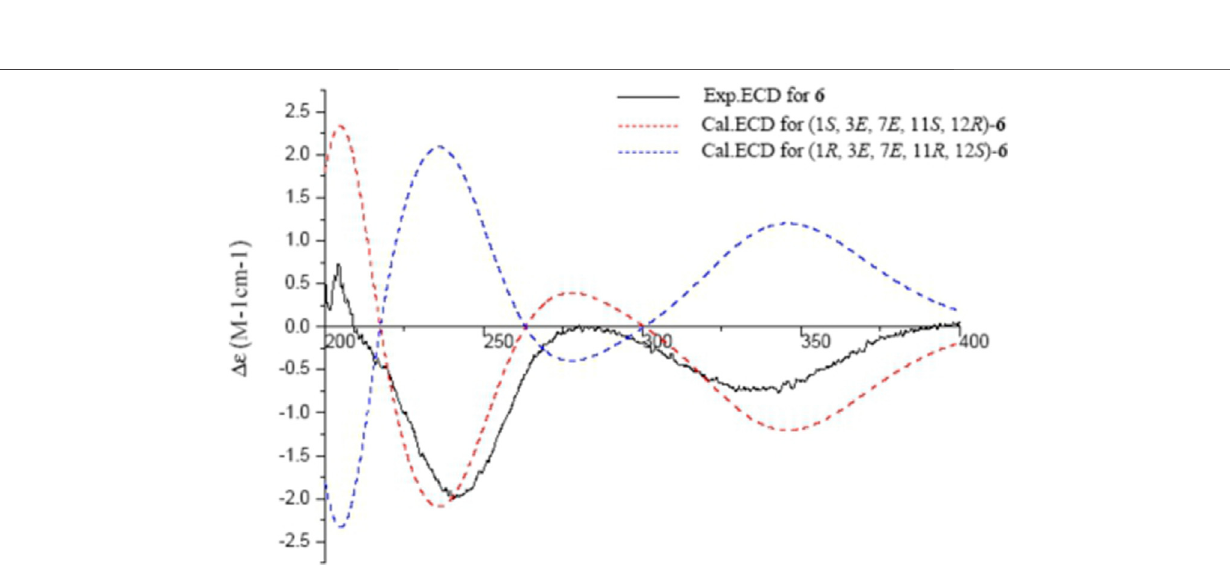
FIGURE7| Experimental and calculatedECDspectraof 6 and its enantiomer(red and bluecalculatedat the B3LYP/6 – 311++G (2d,p)//B3LYP/6 – 31+G (d, p )level in CH 3 OH; black, experimental in CH 3